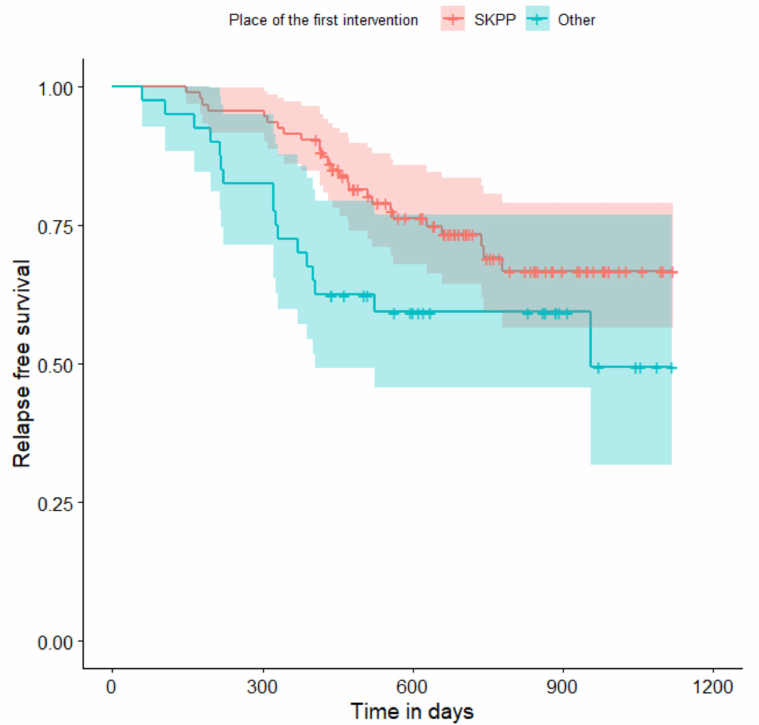
Figure 5. Relapse-free survival curve with 95% CI (darkened area) broken down by place of the first